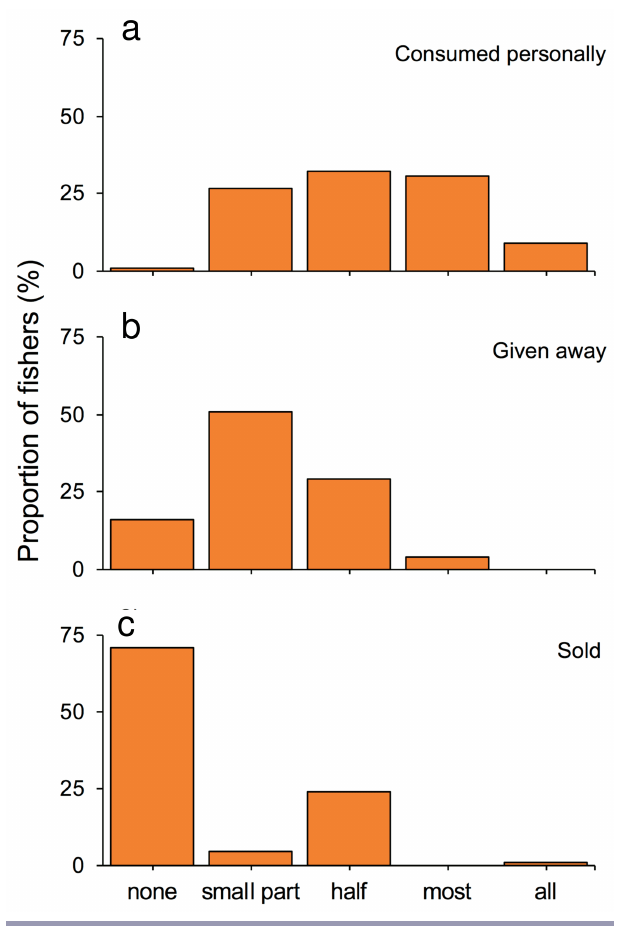
Fig. 3 . Percentage of men and women on Savai’i and Upolu responding to the use of their collected trochus ( Rochia nilotica ).